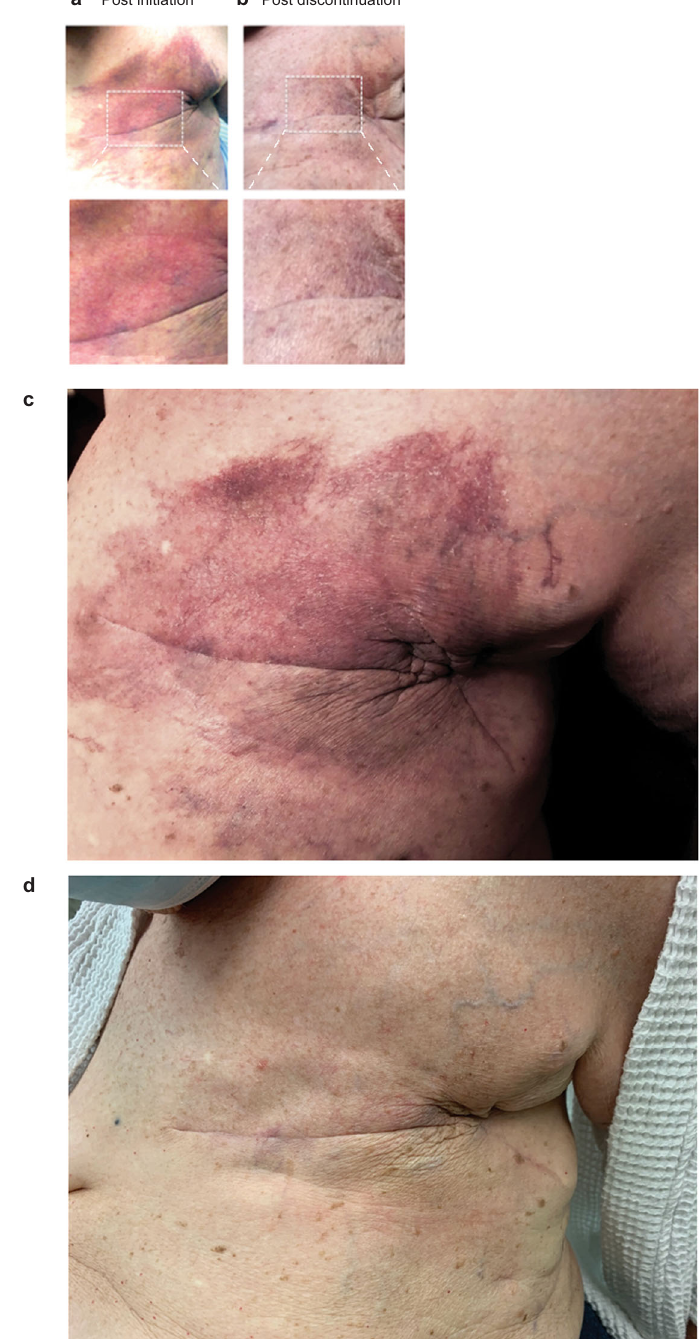
Fig. 1 Letrozole induces radiation recall dermatitis (RRD). a , c Irregular erythematous purpuric patch with telangiectases involving the left chest wall, extending from the sternum to the left axilla at site of previous radiation 3 weeks after initiation of letrozole. b , d Resolution of skin eruption 3 months after discontinuation of